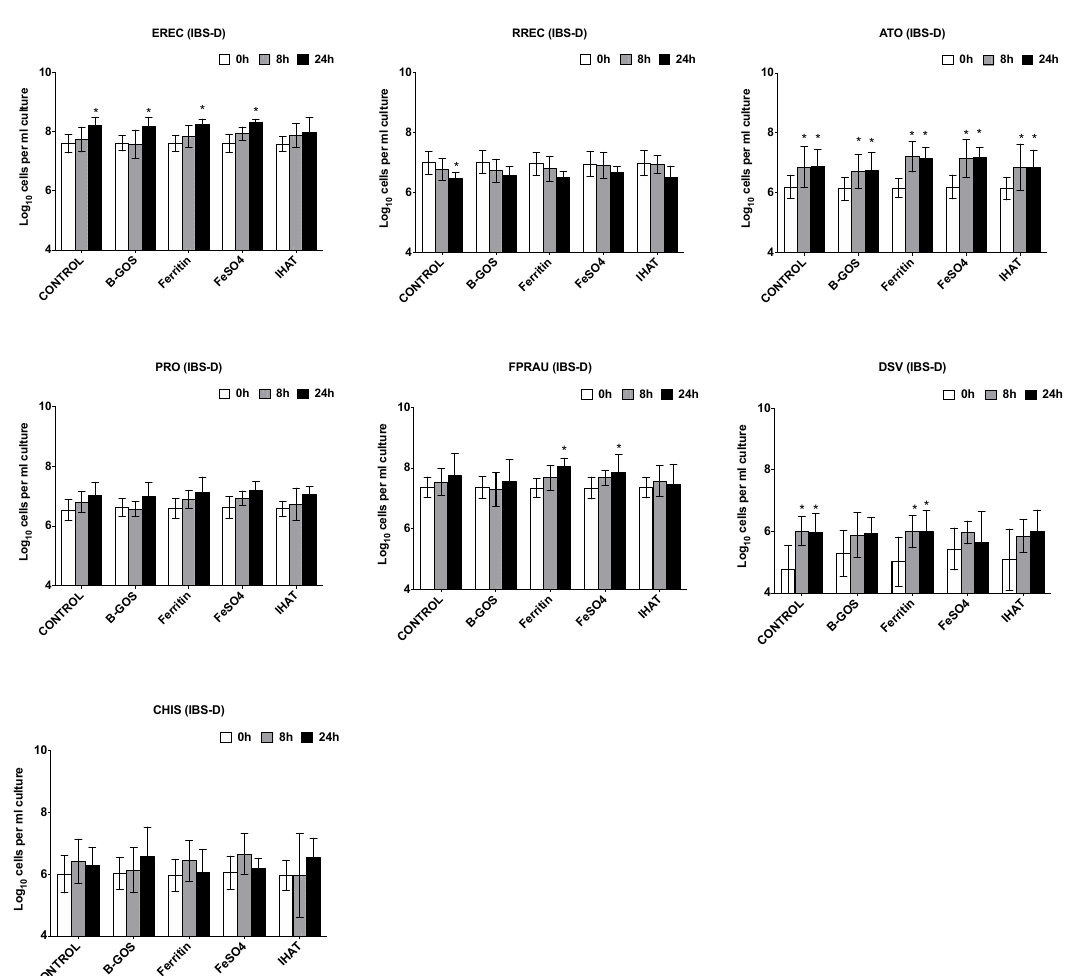
Figure 3. Effect of different substrates on bacterial groups detected by flow-FISH in pH-controlled batch cultures inoculated with faeces from diarrhoea-predominant IBS (IBS-D) donors. Samples were collected at 0 h (baseline), 8 h and 24 h. Target bacteria: Bifidobacterium spp. (BIF), Lactobacillus spp. (LAB), most Bacteroidaceae and Prevotellaceae (BAC), Clostridium coccoides – Eubacterium rectale group (EREC), Roseburia subcluster (RREC), Faecalibacterium prausnitzii (FPRAU), Clostridium cluster IX (PRO), Atopobium – Coriobacterium spp. (ATO), Desulfovibrio (DSV) and Clostridium histolyticum (CHIS). Values are the mean from five independent experiments ± SD. Differences between substrates are not statistically significant. *, significant differences from the baseline condition (i.e., time-point 0 h) for each substrate, p < 0.05.